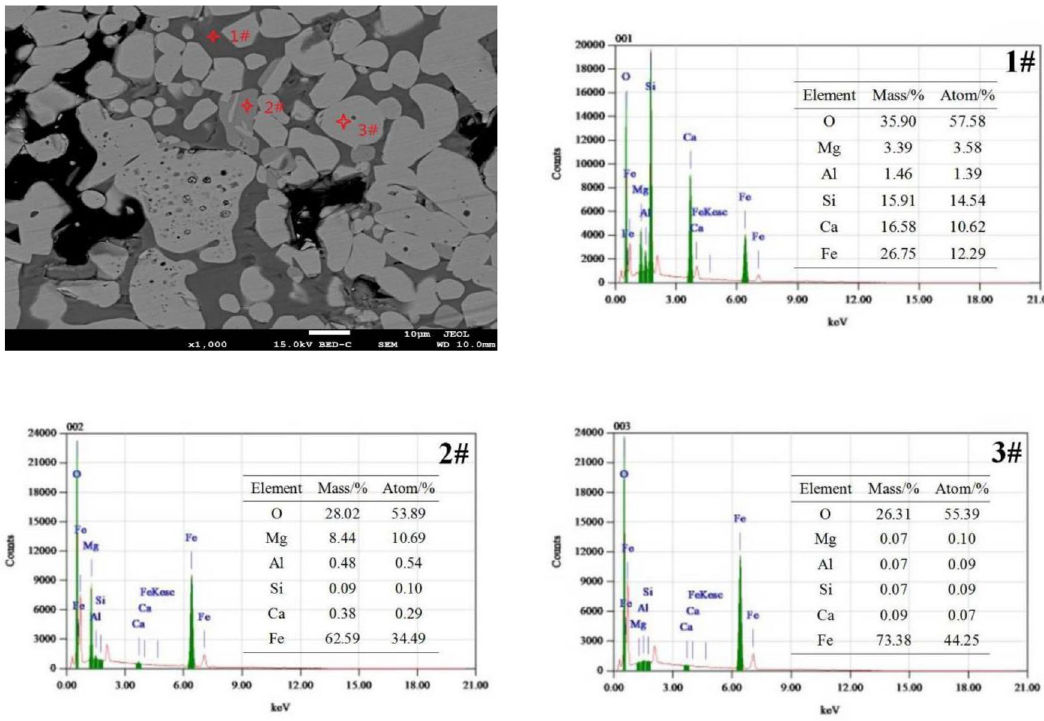
Figure 5. ESD analysis of briquettes with basicity 1.0, MgO 2.0% and SiO 2 5.0%.